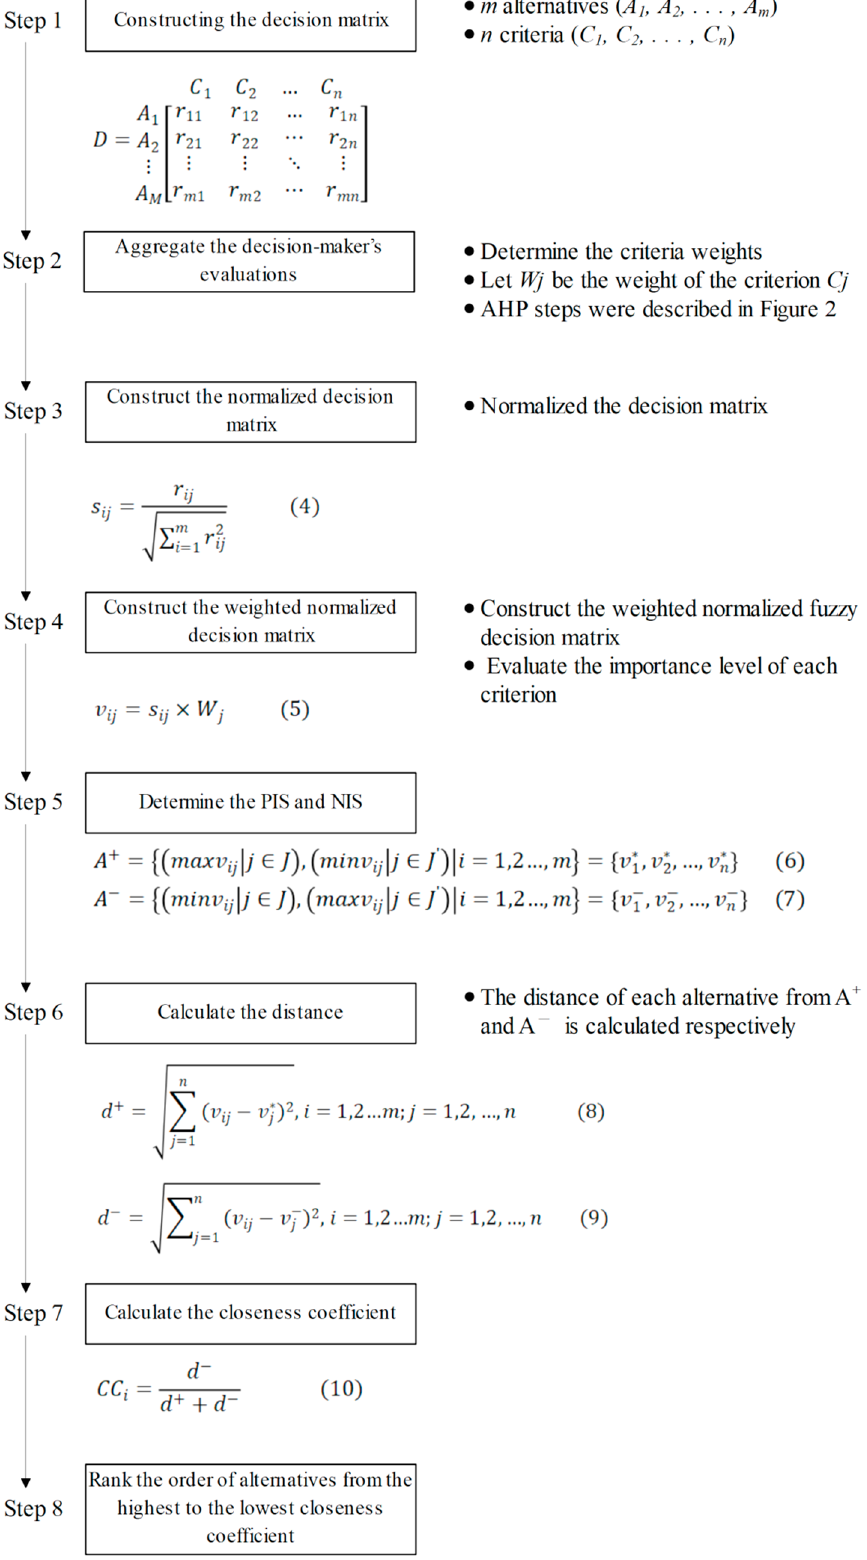
Figure 3. Application process of Technique for Order of Preference by Similarity to Ideal Solution (TOPSIS) (Note: The codes (4) to (10) in this figure represent the formula number used in AHP calculation process; PIS and NIS in this figure represent Positive Ideal Solution and Negative Ideal Solution, respectively).